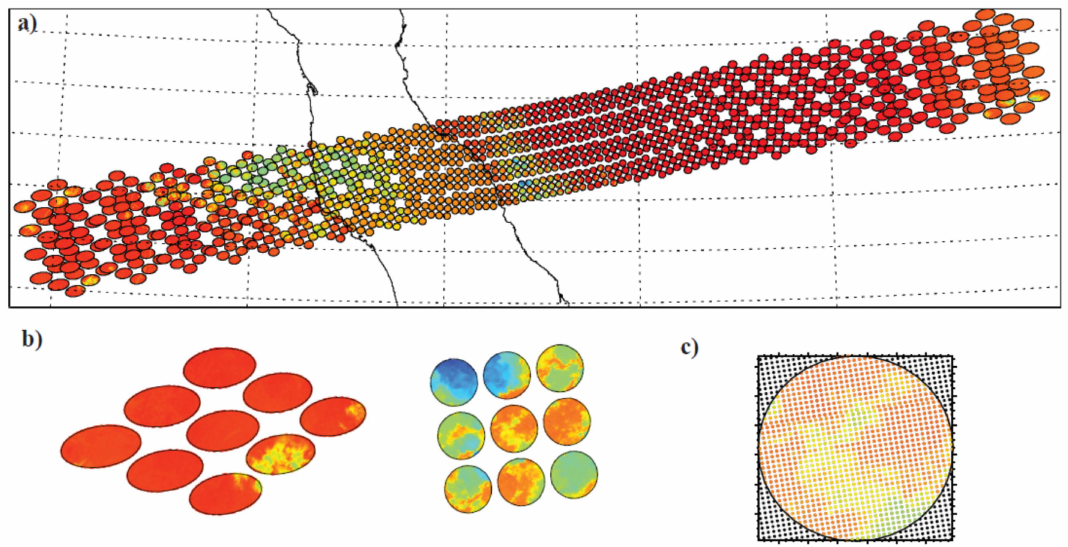
Figure 7. Collocated VIIRS pixels within the CrIS FOVs, including ( a ) the four scans shown in Figure 3; ( b ) the enlarged images for FOR 1 and 15 in the first scan line (from the bottom up) with scan angles of − 48.3 ◦ and − 1.65 ◦ ; and ( c ) the enlarged plot for the center FOV (FOV 5) in the FOR 15 in the first scan, where the colorful points indicate VIIRS pixels falling within the CrIS FOV and the black ones represent those outside CrIS FOVs. Note that CrIS FOV shapes shown as black lines are independently computed using CrIS geolocation dataset and the FOV angle of 0.963 ◦